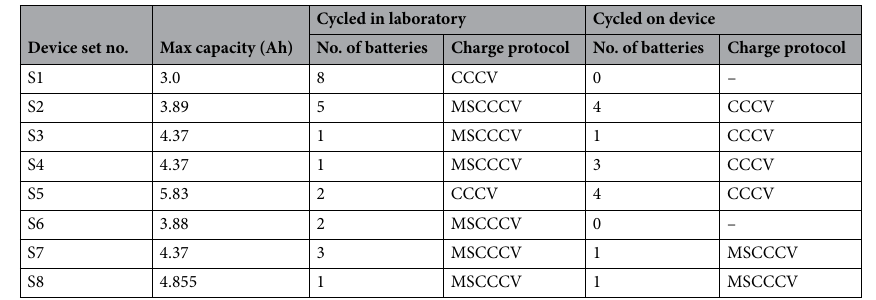
Table 6. Batteries used in experiments.